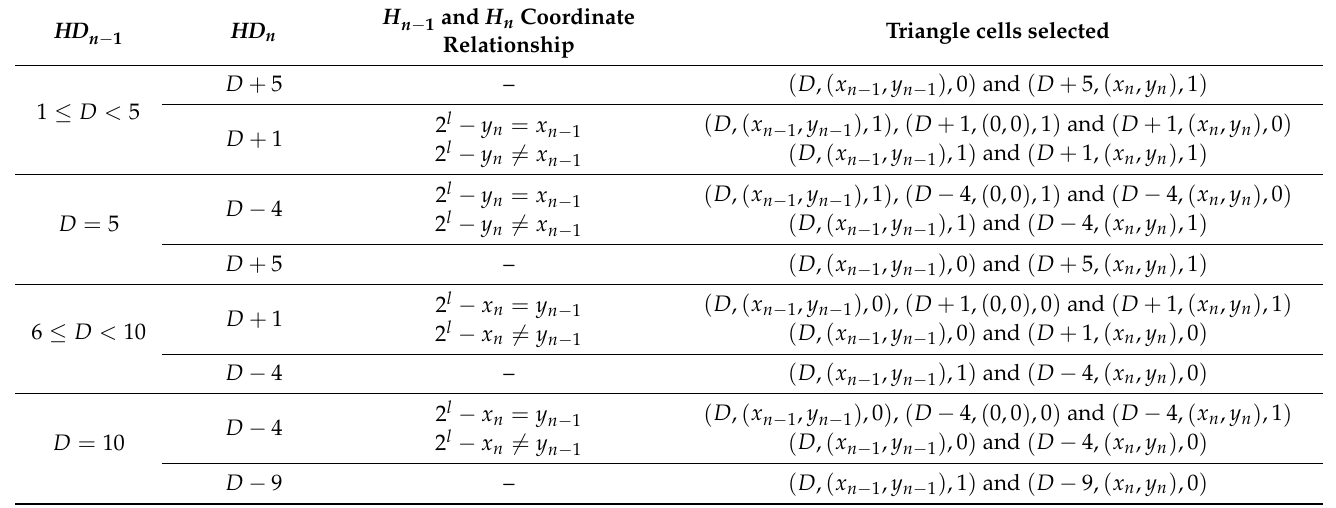
Table 10. Htotcode rule of the ( n − 1)th hexagon cell C 2 .